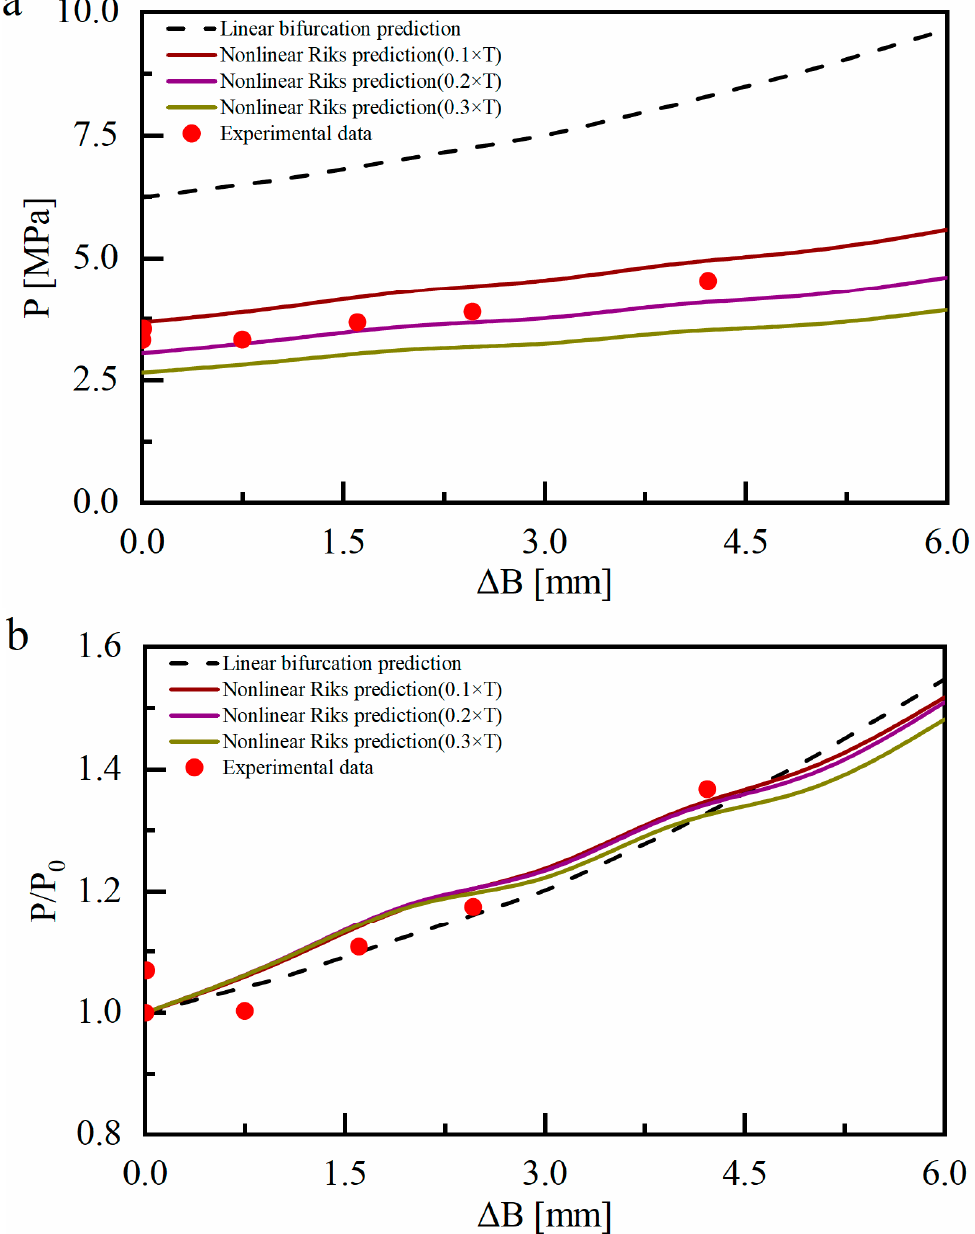
Figure 19. Buckling loads ( a ) and their normalised values ( b ) for one preform and five bi-segment bulged hulls obtained from numerical and experimental analyses.